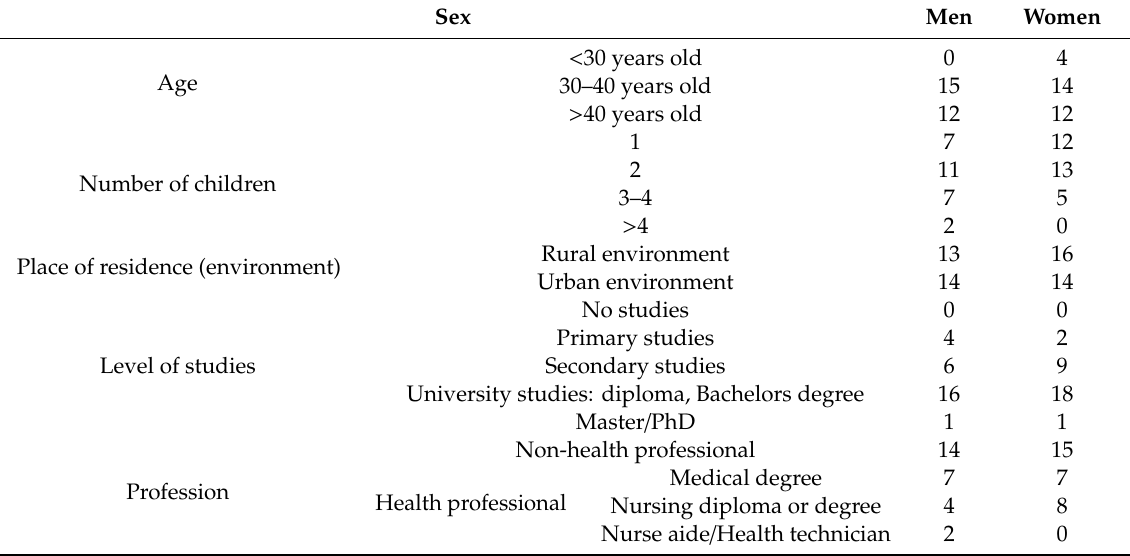
Table 1. Main characteristics of the parents participating in the focus